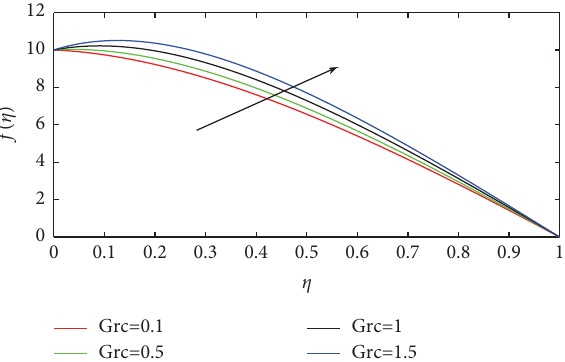
Figure 5: Velocity profles for the diferent values of Gr